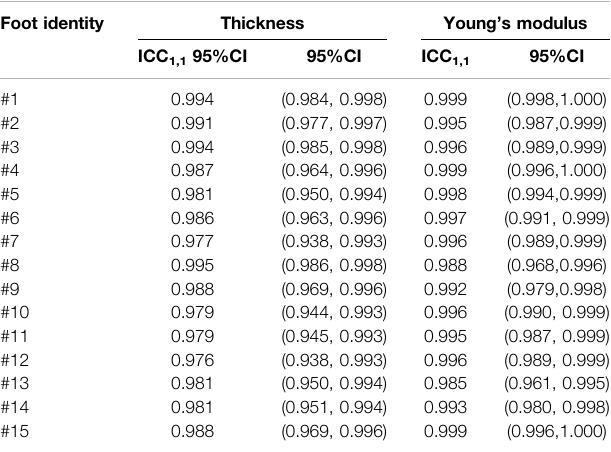
TABLE 1 | Intragroup correlation results of thickness and Young ’ s modulus in 15 fl exible fl